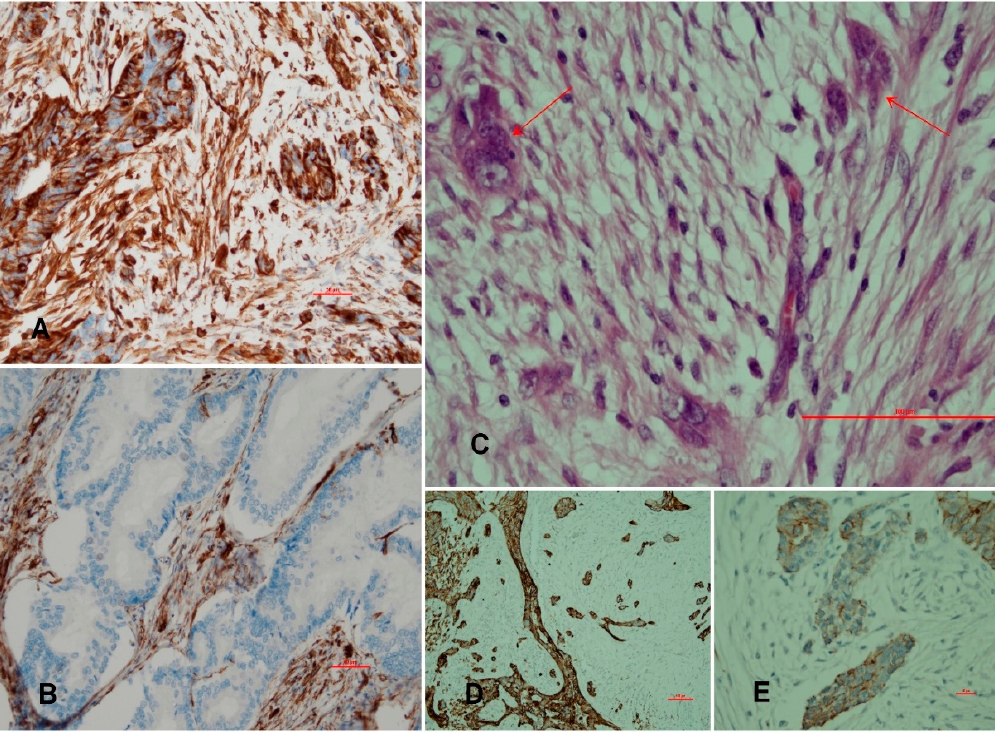
Figure 2. The compilation of five pictures representing of EMT and tumor budding in aspect of FGFR-2 mutation ( p = 0.000). ( A ) Vimentin+ singular cancer cells forming small groups. ( B ) Vimentin+ stromal cells. Note the lack of expression in well-formed glands. ( C ) H&E staining showing small groups (arrows) of pleomorphic and spindle cells. ( D ) Pancytokeratin staining showing singular and small buds of cancer cells as an example of tumor budding. ( E ) A focal lack of E-cadherin leads to a gradual loss of epithelial characteristics.